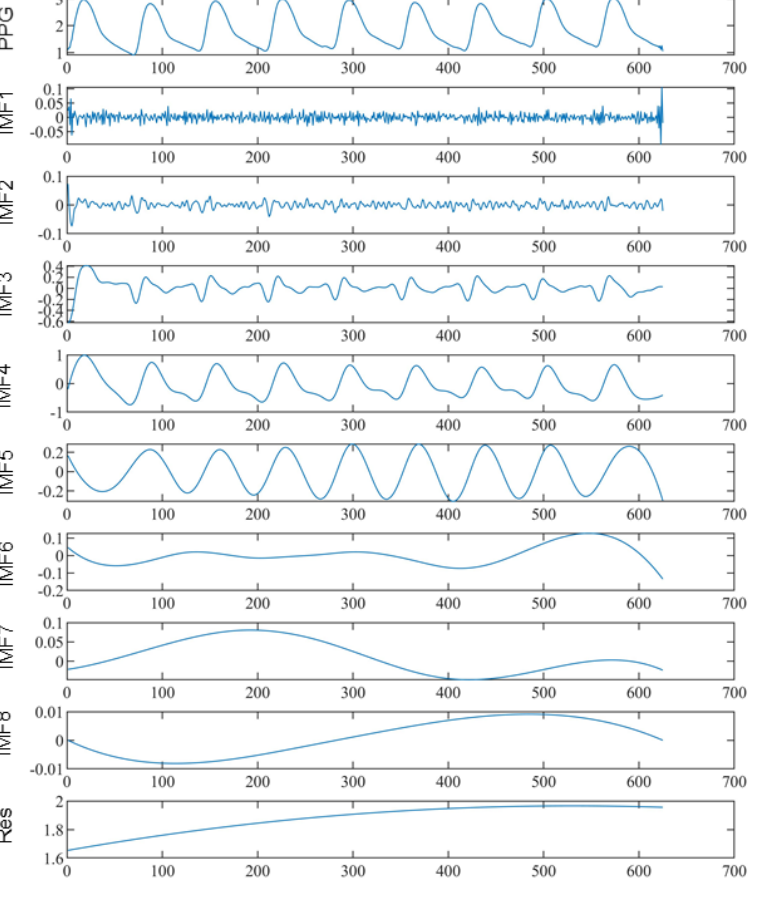
Table 3. Results of each model on the dataset augmented with EEMD.